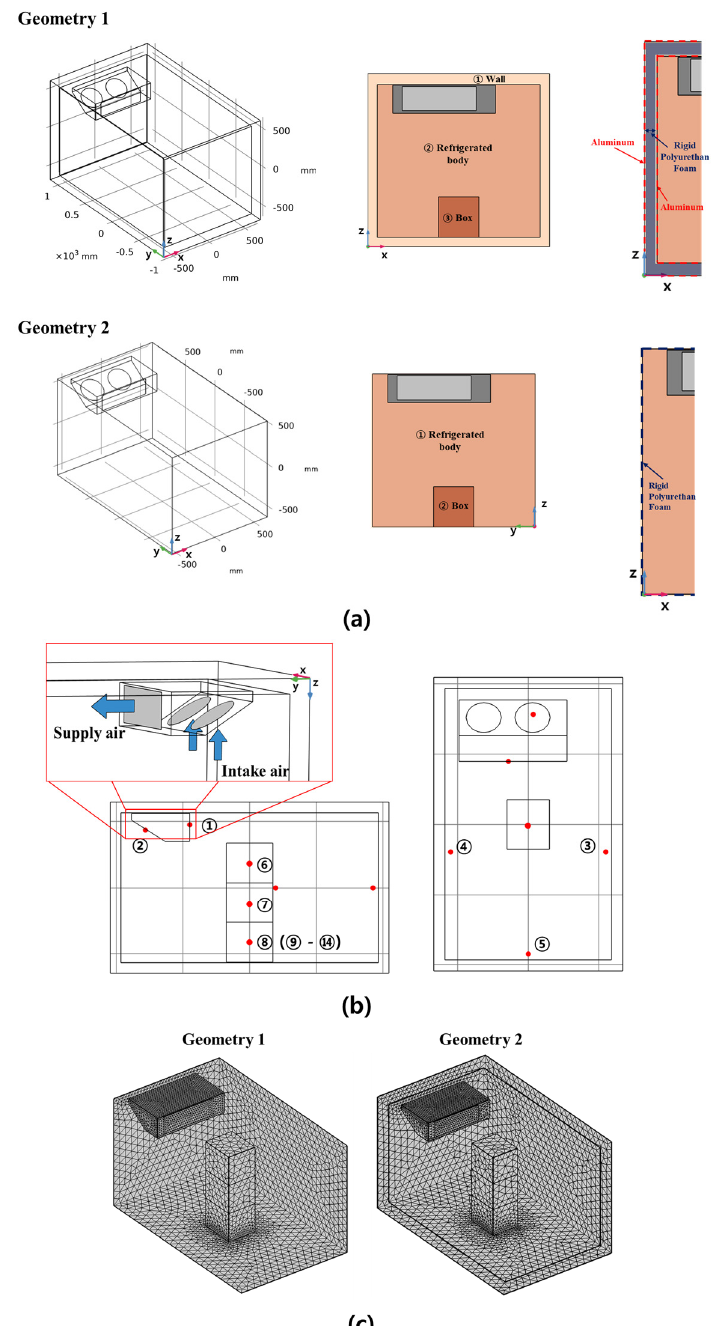
Figure 4. ( a ) Geometries of refrigerated body used in the simulation (1) Body with insulation wall (2) Body without insulation wall ( b ) Temperature measurement points and refrigerator boundary conditions in simulation ( c ) grid mesh of model .